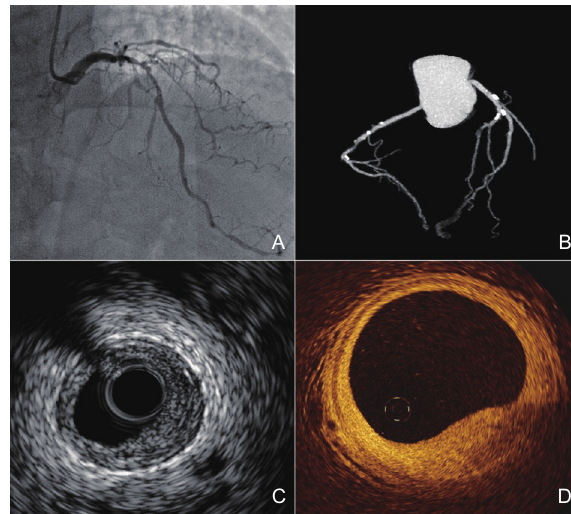
Figure 2 Coronary artery imaging. (A) The left main trunk with sever LAD stenosis was shown in DSA; (B) The left main trunk and the RCA with calcifications were illustrated by CTA; (C) The plaque was shown in a coronary artery by intravascular ultrasound; (D) OCT imaging for the intravascular plaque of coronary artery.